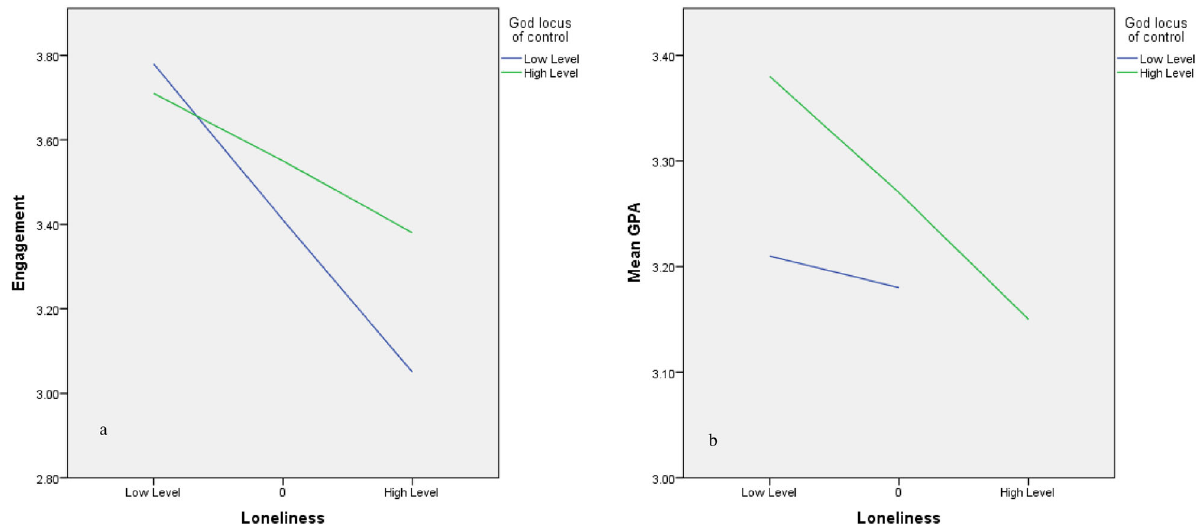
Fig. 2 The moderating effect of GLC. a The moderating effect of the GLC on the relationship between loneliness and engagement; b the moderating effect of the GLC on the relationship between loneliness and academic